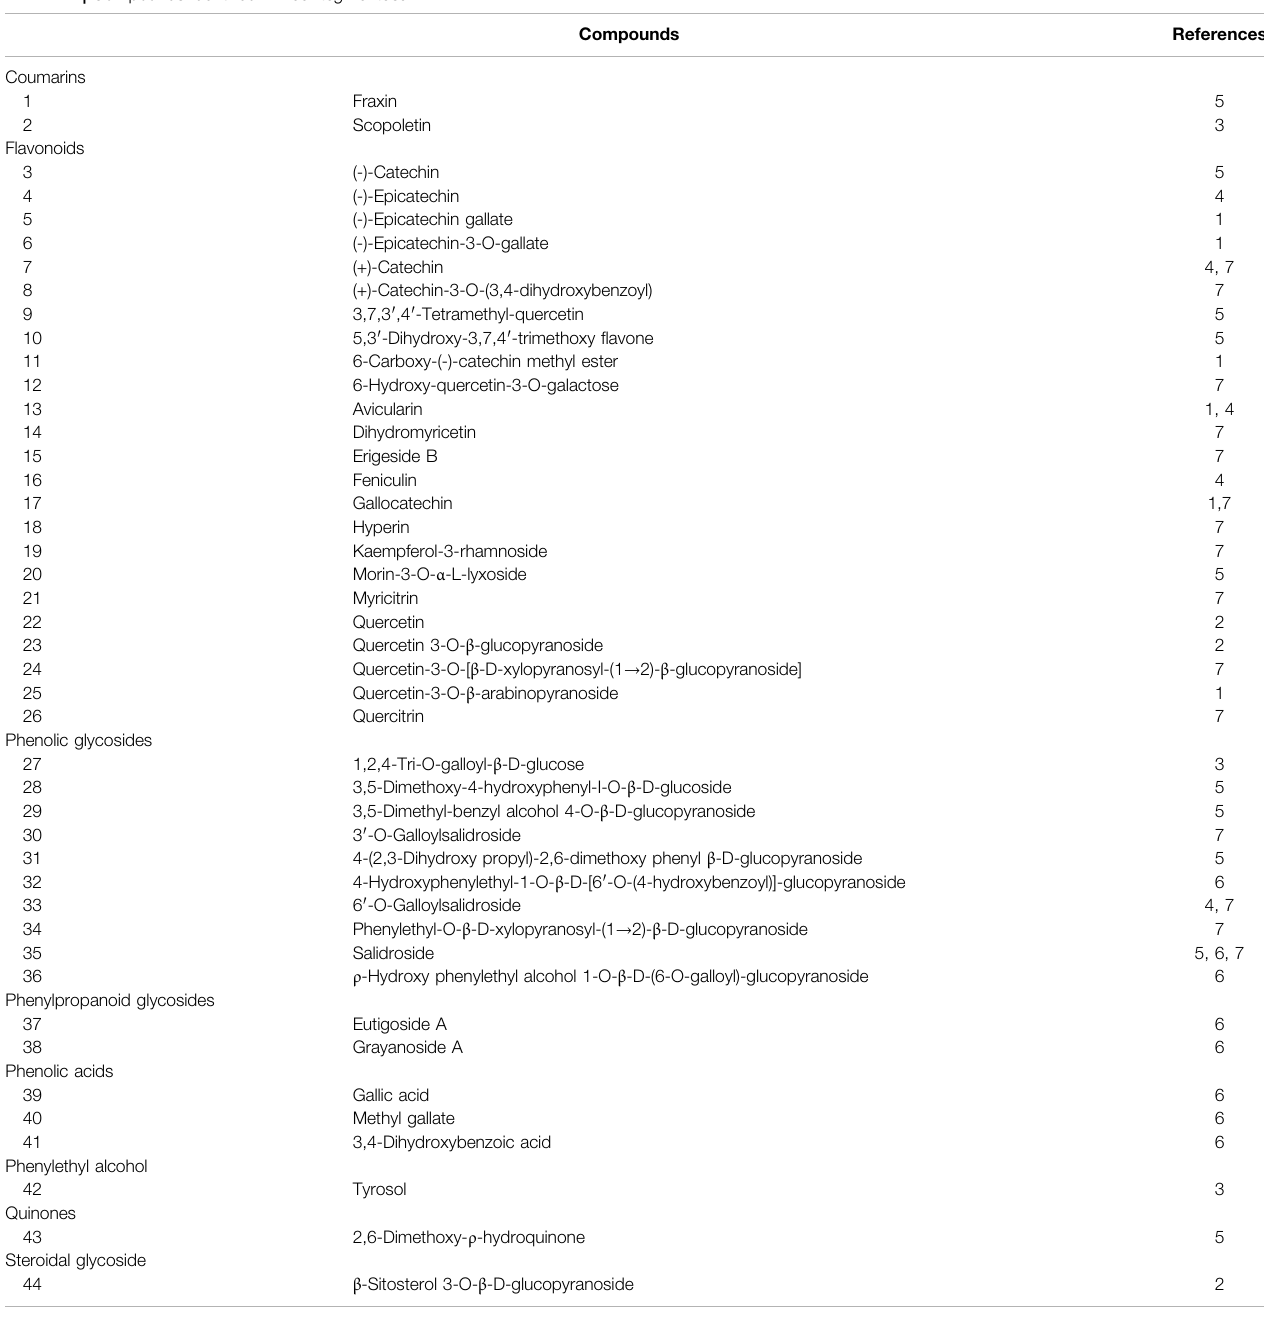
TABLE 1 | Compounds identi fi ed in Acer tegmentosum .